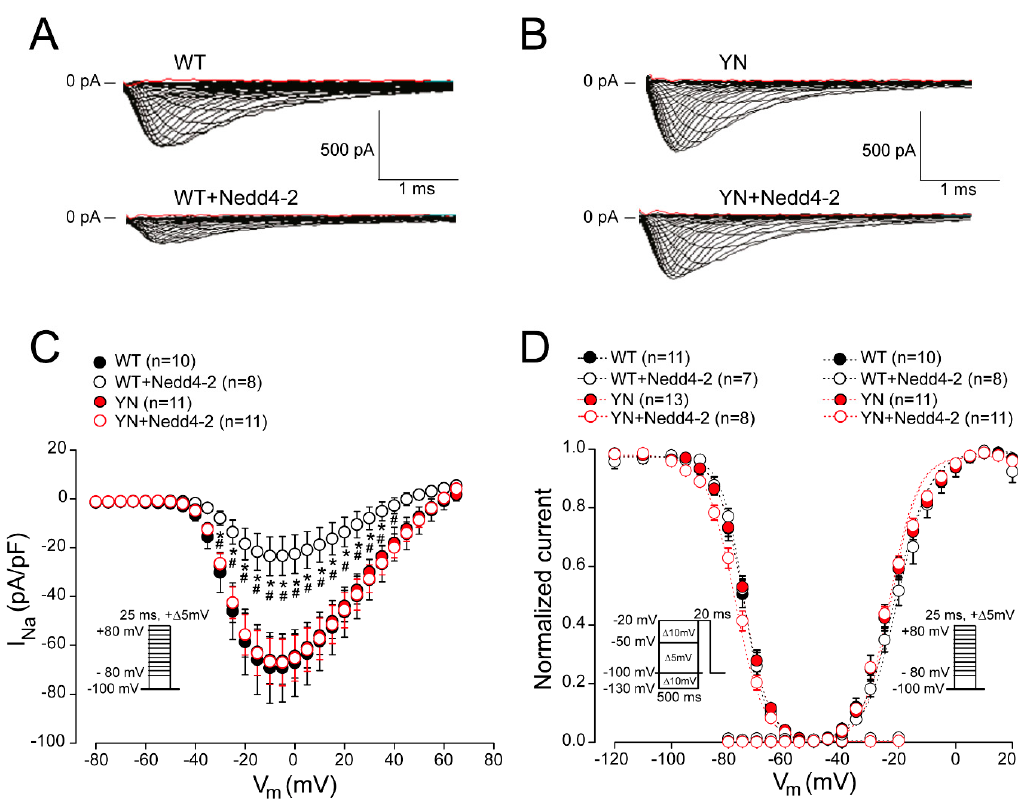
Figure 2. Nedd4-2-dependent regulation of sodium current is abrogated by the SCN5A -p.Y1977N mutation in HEK293 cells. Typical example of sodium current recordings obtained from HEK293 cells transiently transfected with SCN5A wild-type (WT) ( A ) or SCN5A -p.Y1977N (YN) ( B ) with or without Nedd4-2. Average sodium current-voltage relationship ( C ) and voltage dependence of activation and inactivation ( D ) for HEK293 cells transiently transfected with SCN5A WT or YN, in the presence and absence of Nedd4-2. n indicates the number of cells. Insets: voltage clamp protocols. * p < 0.05 vs. WT, # p < 0.05 vs. YN + Nedd4-2; two-way repeated measures ANOVA followed by Holm–Sidak test for post-hoc analysis.